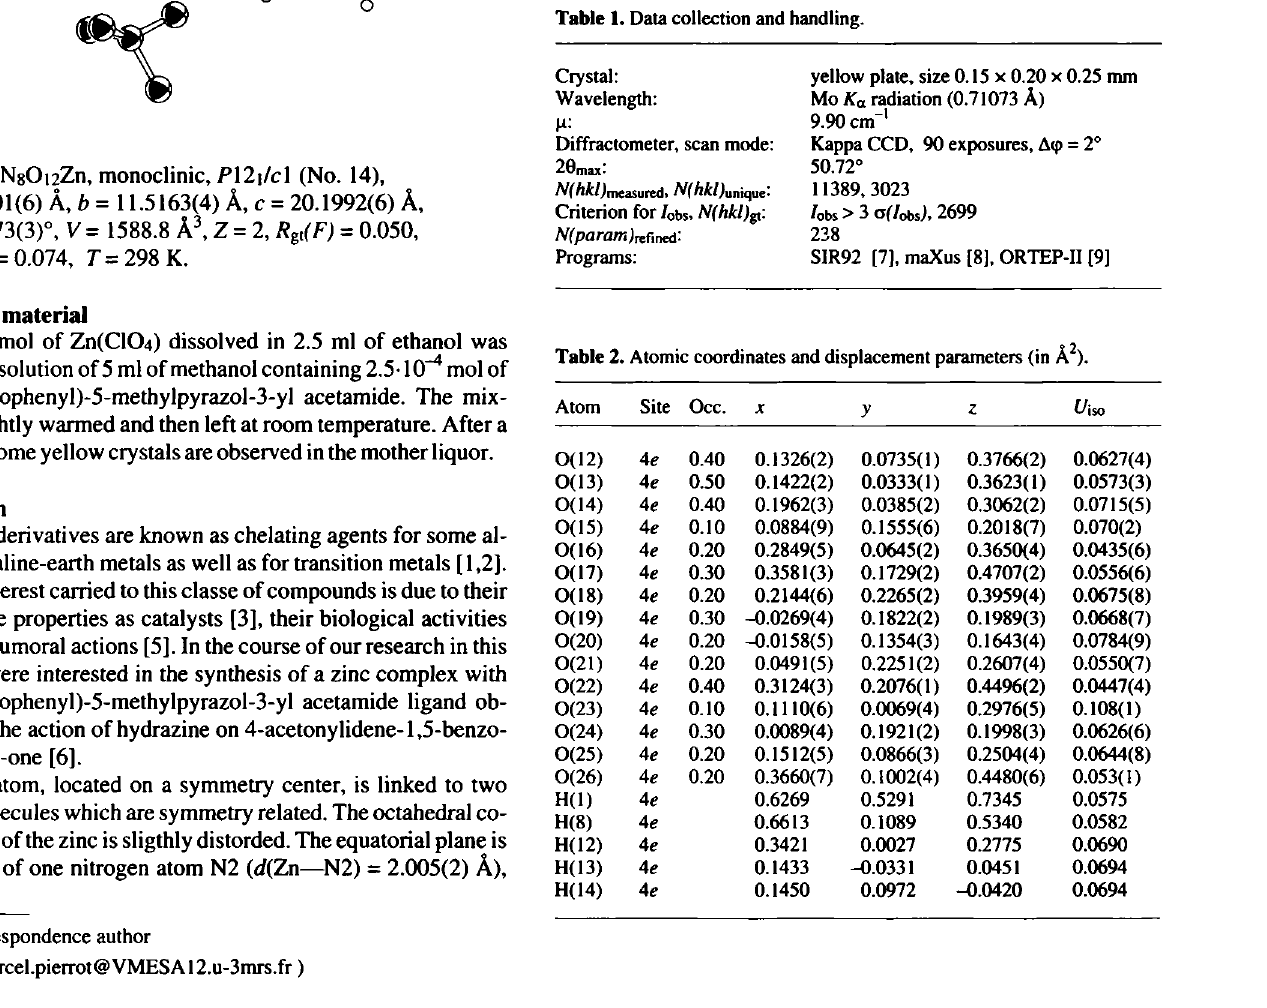
Table 1. Data collection and handling.